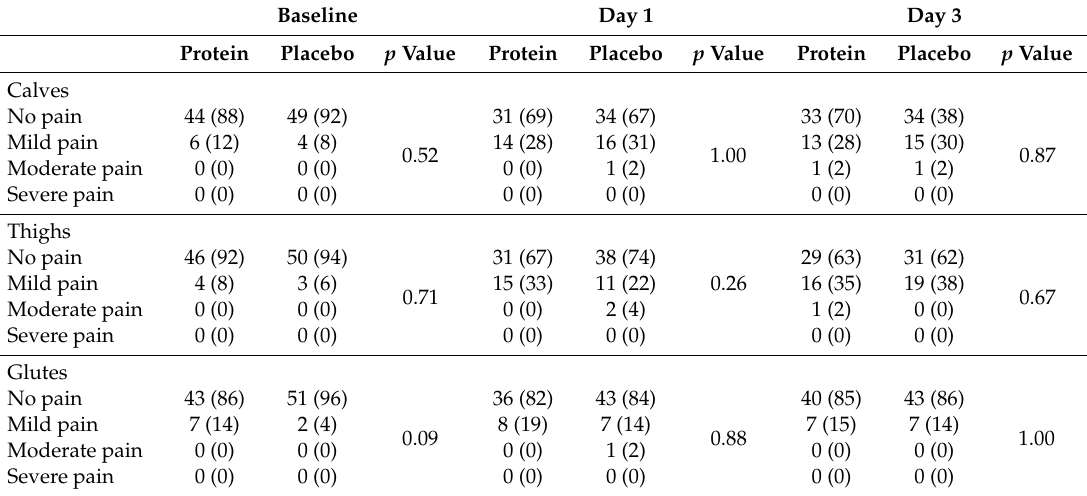
Table 4. Categorical analysis of muscle soreness during moderate-intensity